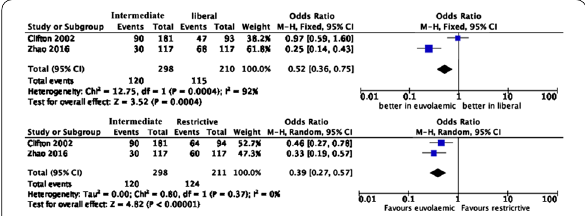
Figure. Forrest plot on Neurological Outcomes of Intermediate vs Liberal Fluid balance and Intermediate vs Restrictive fluid balance.